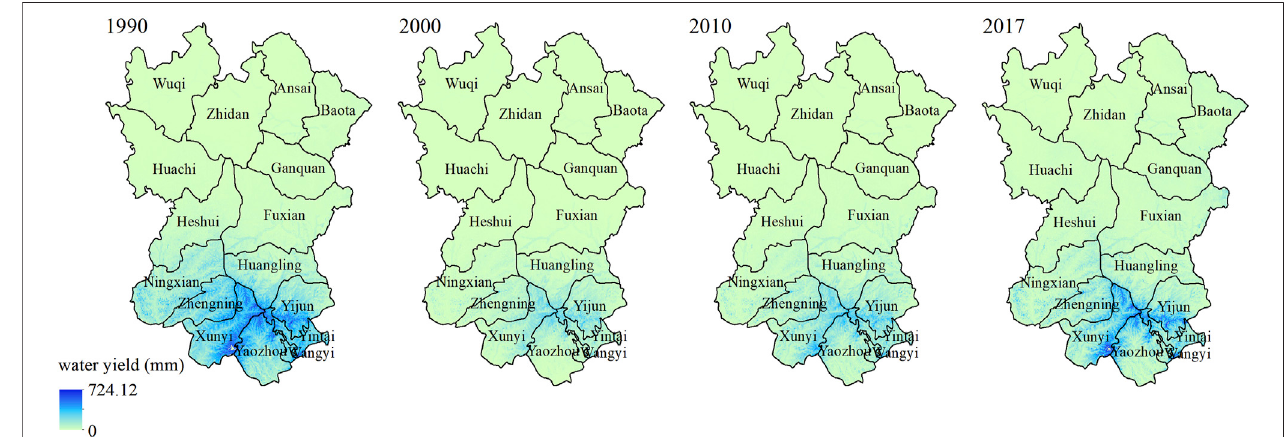
FIGURE 3 | Spatiotemporal variation in water yield service in the ZMR from 1990 to 2017.